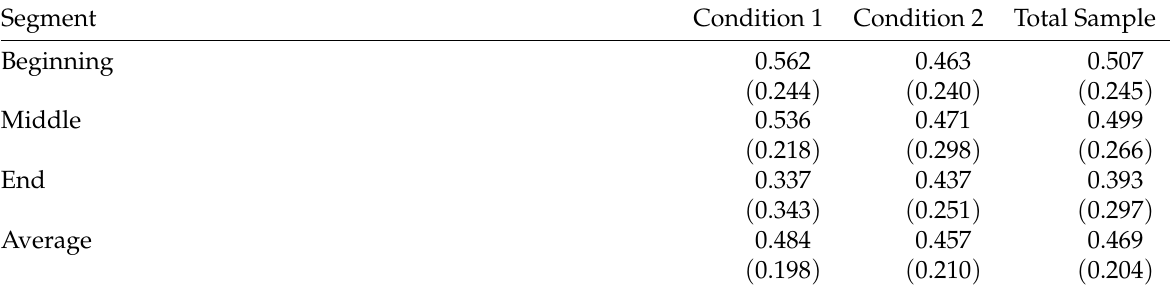
Table 2: Bivariate correlations demonstrating convergence in FFT values ( N = 41